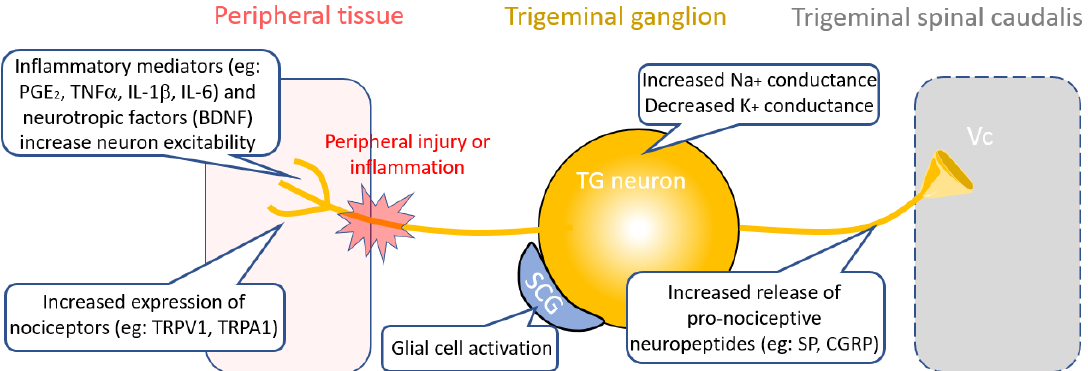
Figure 2. Peripheral mechanisms of trigeminal neuropathic pain. Peripheral nerve injury releases inflammatory mediators including prostaglandin E 2 (PGE 2 ), cytokines and neuropeptides including brain-derived neurotrophic factor (BDNF), which sensitizes peripheral nerve terminals by depolarizing nociceptors. Expression of peripheral receptors including the transient receptor potential vanilloid 1 (TRPV1) and transient receptor potential cation channel, subfamily A, member 1 (TRPA1). Changes in ion channel expression and activity on trigeminal neurons increases excitability as do activated satellite glial cells (SCG), which increase in number. Excitability of the TG neurons leads to increased release of neuropeptides substance P (SP) and calcitonin gene-related peptide (CGRP) to postsynaptic regions in the trigeminal spinal caudalis (brain stem).